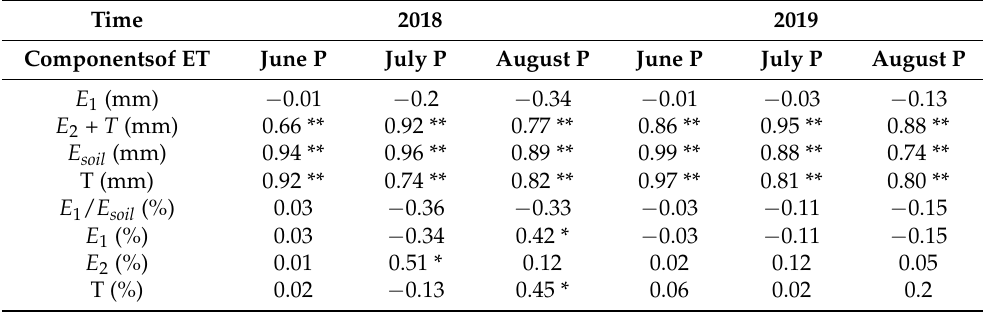
Table 1. Correlation between precipitation and evapotranspiration flux components.